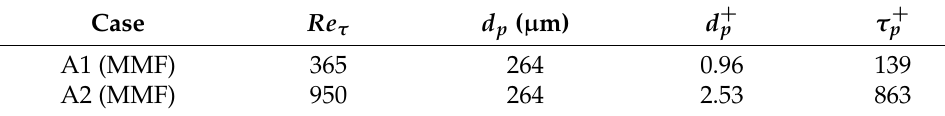
Table 6. Particles characteristics of the higher- Re τ simulations.